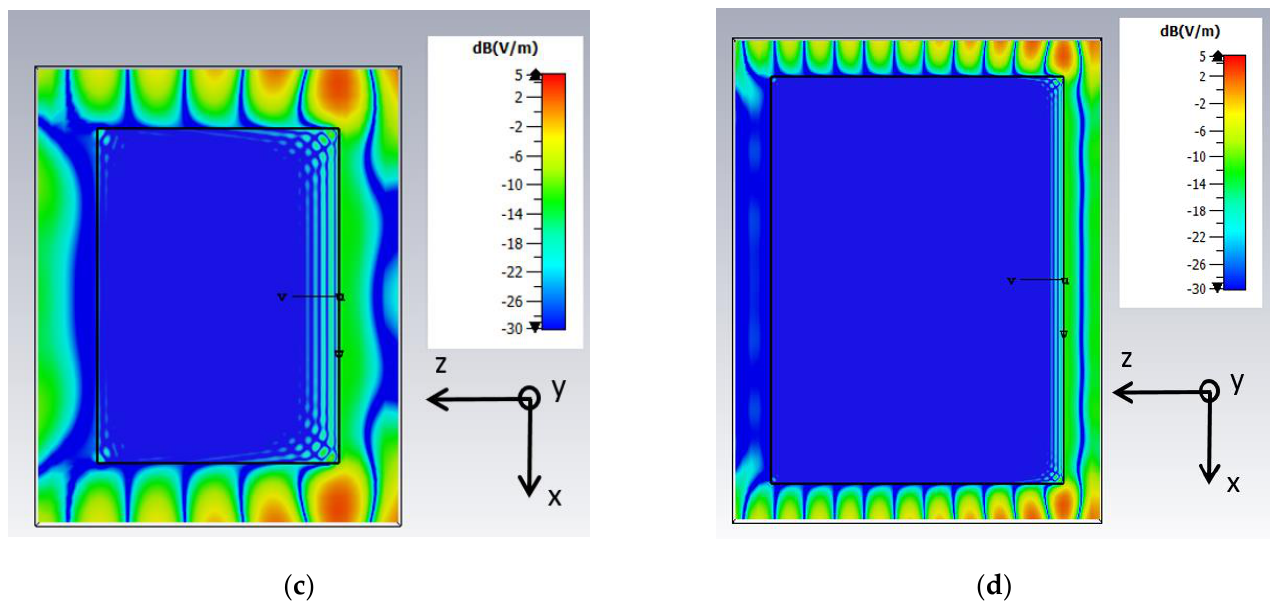
Figure 4. Top view (355 mm × 255 mm) of simulated electric field distribution of a 355 mm × 160 mm × 255 mm trunk phantom model: ( a ) f = 402 MHz, ( b ) f = 868 MHz, ( c ) f = 2.45 GHz and ( d ) f = 5.8 GHz.